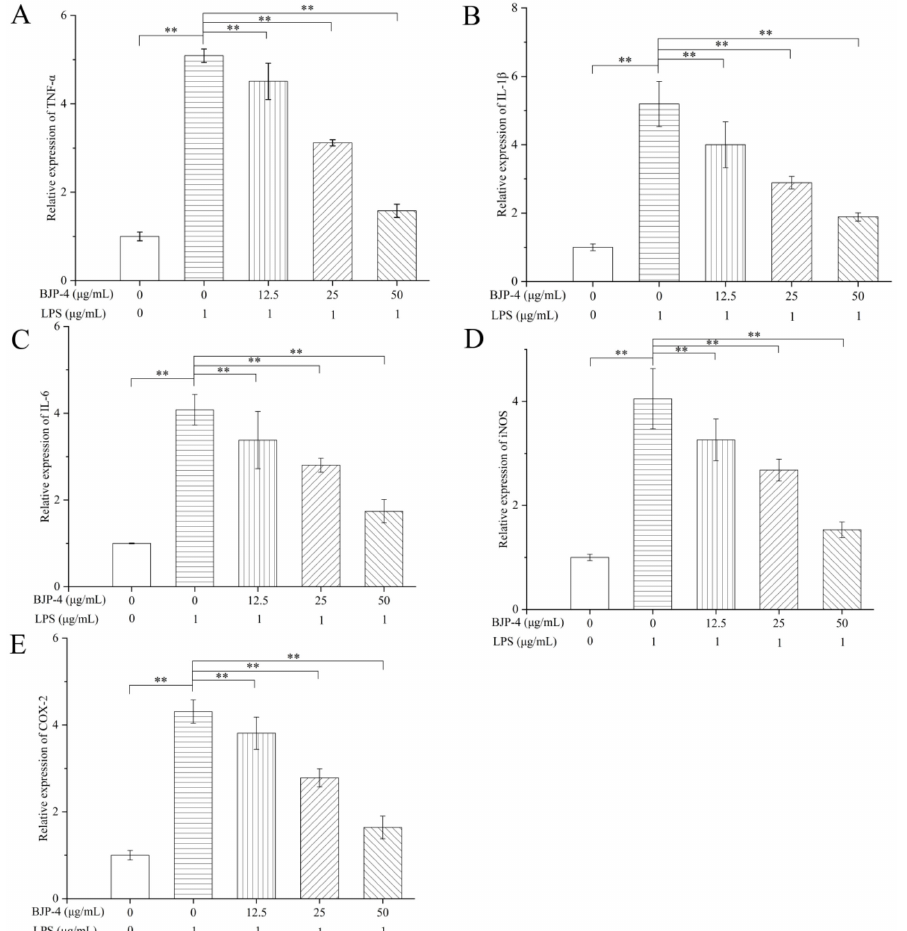
Figure 4. Effects of BJP-4 on LPS-stimulated mRNA expressions: ( A ) The mRNA levels of TNF- α , ( B ) IL-1 β , ( C ) IL-6, ( D ) iNOS, ( E ) COX-2. Values are expressed as mean ± SD. ** p <